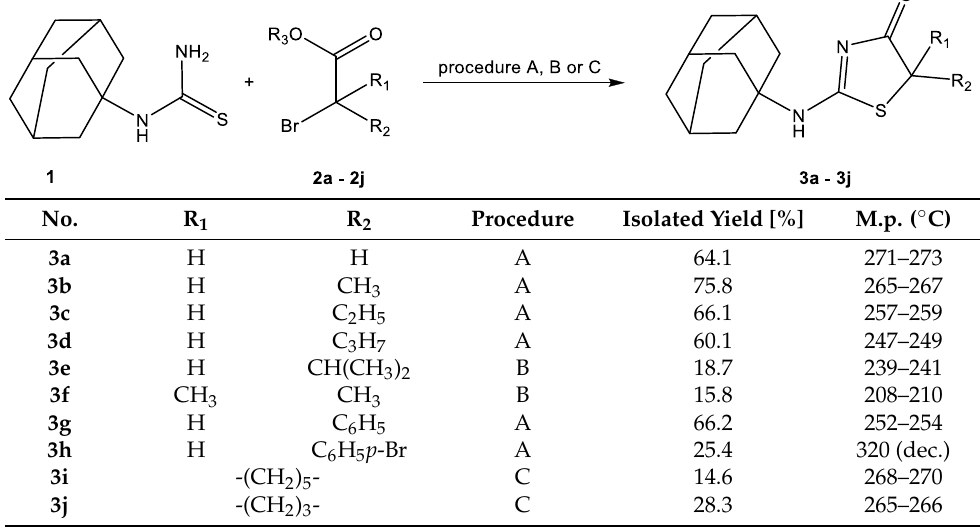
Table 1. Synthesis of 2-(adamantan-1-ylamino)thiazol-4(5 H )-one.